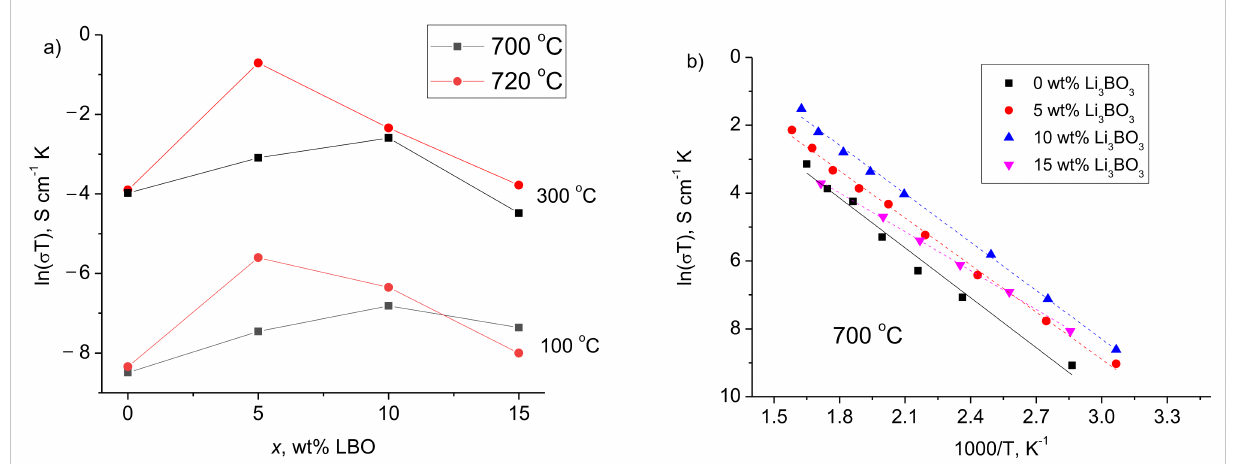
Figure 4. Impedance plots of LiCoO 2 |c-LLZ and LiCoO 2 + 5 wt% Li 3 BO 3 |c-LLZ half-cells at 50 ( a ) and 300 ◦ C ( b ).